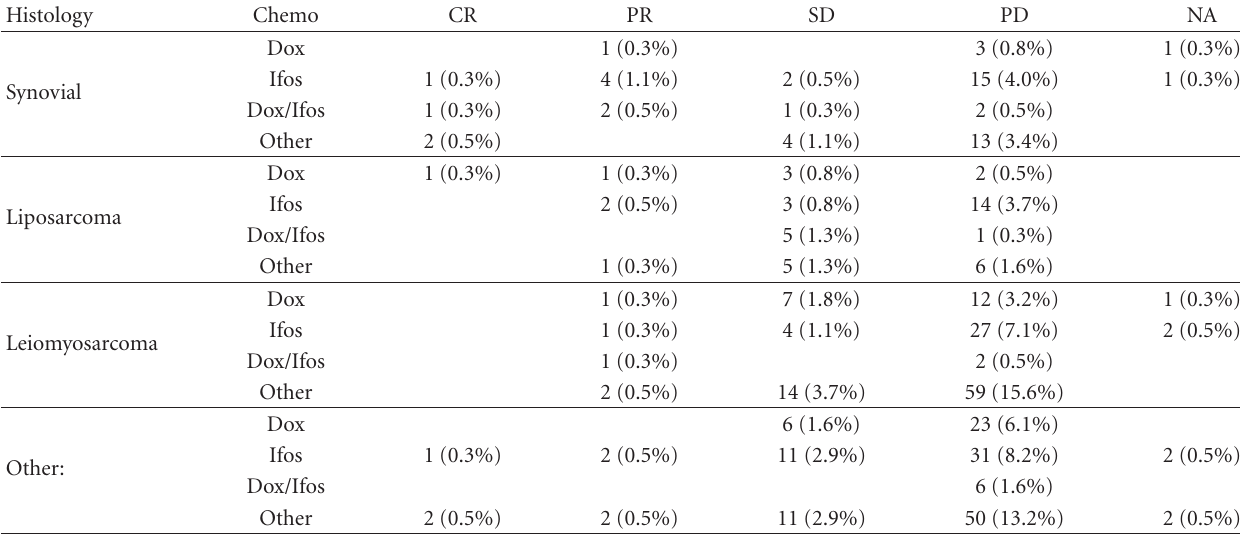
Table 3: Response to second-line chemotherapy according to pathology and